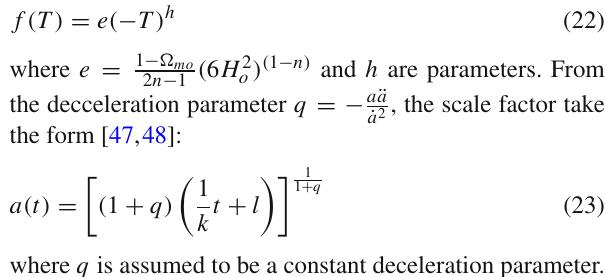
Fig. 1 Thevariationsofenergydensity ρ DE ofDarkenergyisdepicted in the graph. The graphs are plotted for h = 3 / 2, k = 3 / 4, e = 5 /